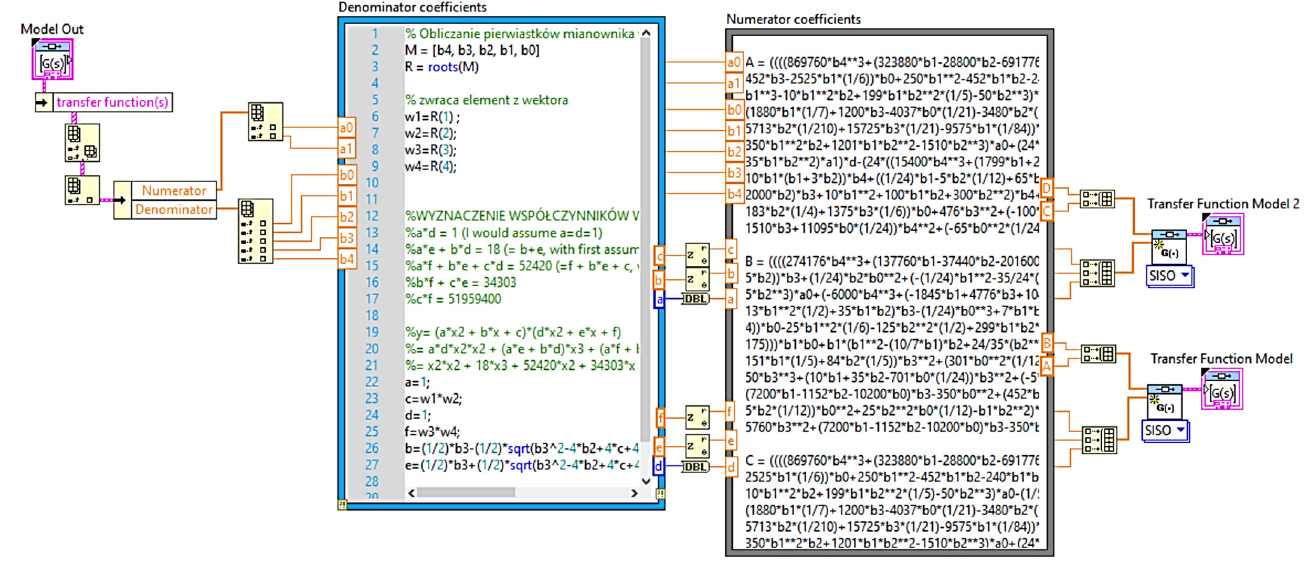
Figure 5. View of a window with a code fragment of the steering frequency analysis program. The Formula Node structure takes three times as many characters, but even this may sometimes prove to be too few. However, this can be easily remedied by splitting the description of each coefficient into a single structure. This is also consistent with the idea of programming because the main code of the program should be divided into a subprogram. Finally, the operation of the described program is presented in the diagram below (Figure 6). It is only one-quarter of the whole, but the remaining parts perform exactly the same calculations.